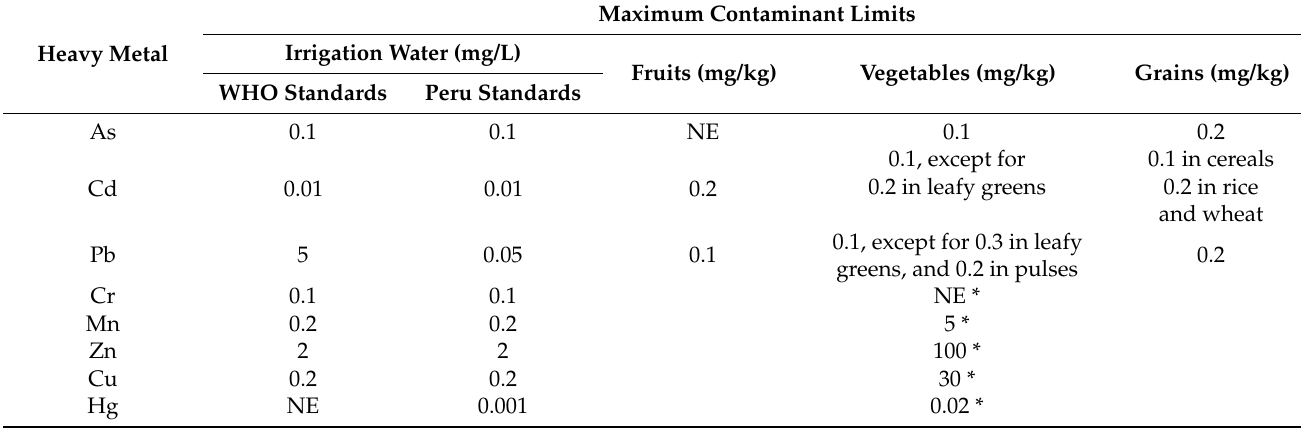
Table 1. Heavy-metal quality standards for agricultural water and produce in Peru. Data adapted from the Food and Agicultural Organization and the World Health Organization (FAO/WHO), and the Ministry of the Environment [12,17]. Maximum Contaminant Limits Irrigation Water (mg/L) Heavy Metal Fruits (mg/kg) Vegetables